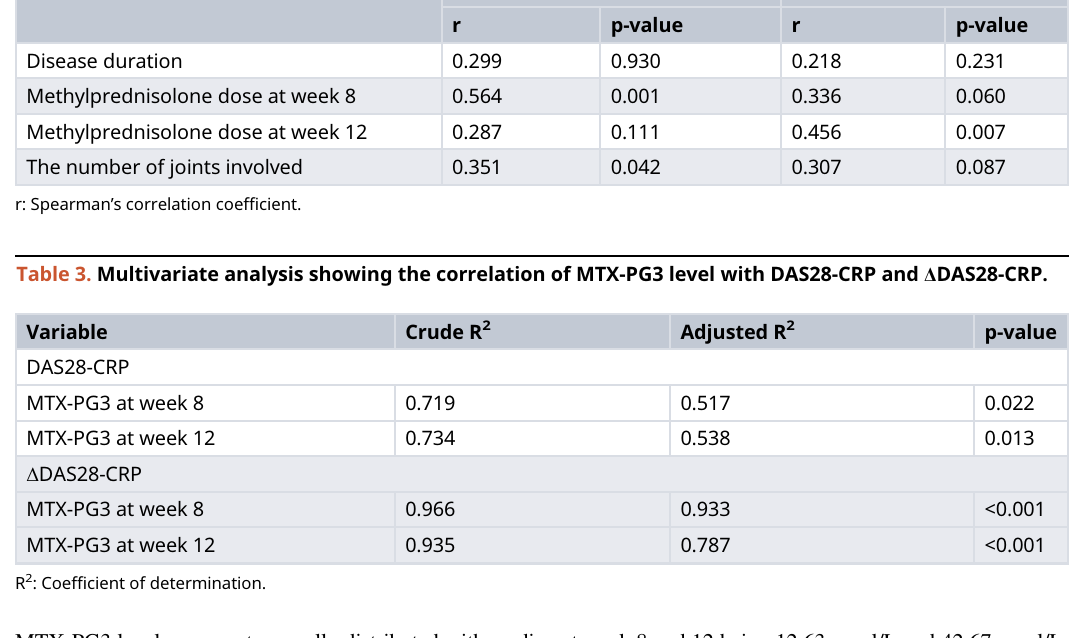
Table 2. Spearman ’ s correlation showing the potential confounding variables associated with DAS28-CRP. Variable